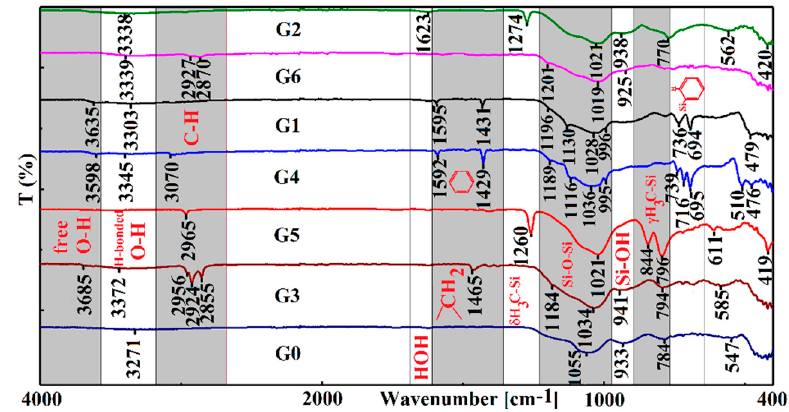
Figure 1. Attenuated Total Reflectance (ATR)-Fourier Transform Infrared (FTIR) spectra of fluorescent silica hybrids.